Question: Summarize what this figure shows in one sentence.
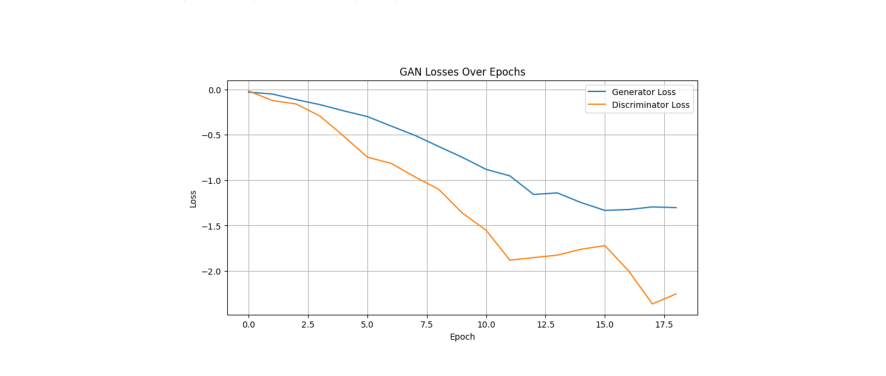
Answer: The figure illustrates the progression of Generator and Discriminator losses over training epochs in the Generative Adversarial Network (GAN), showcasing how the model refines generative and discriminative capabilities during learning.